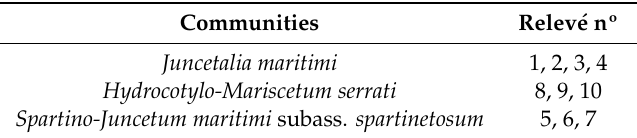
Table 2. Plant communities identified in the phytosociological